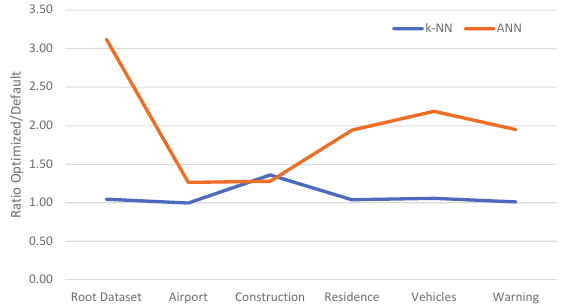
Figure 12. Average execution time of the classifiers based on their